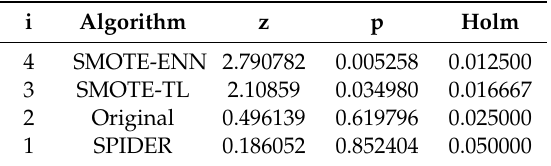
Table 24. Results of the Holm test comparing the performance of the Extended Gamma classifier after hybrid algorithms. The test rejects the hypothesis having an unadjusted p -value ≤ 0.016667.